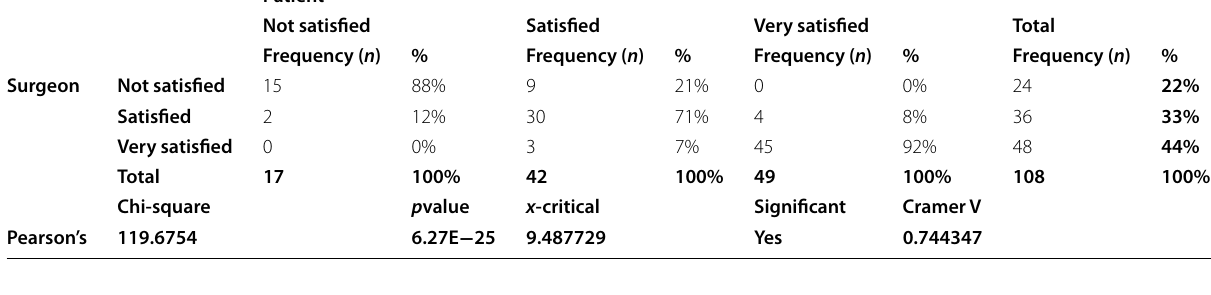
Table 5 Satisfaction level of patients and surgeon